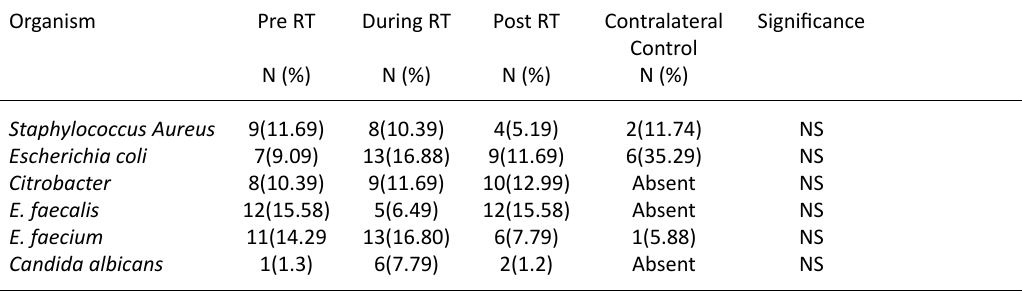
Table 3. Bacterial and yeast type representation in cases and control group Organism